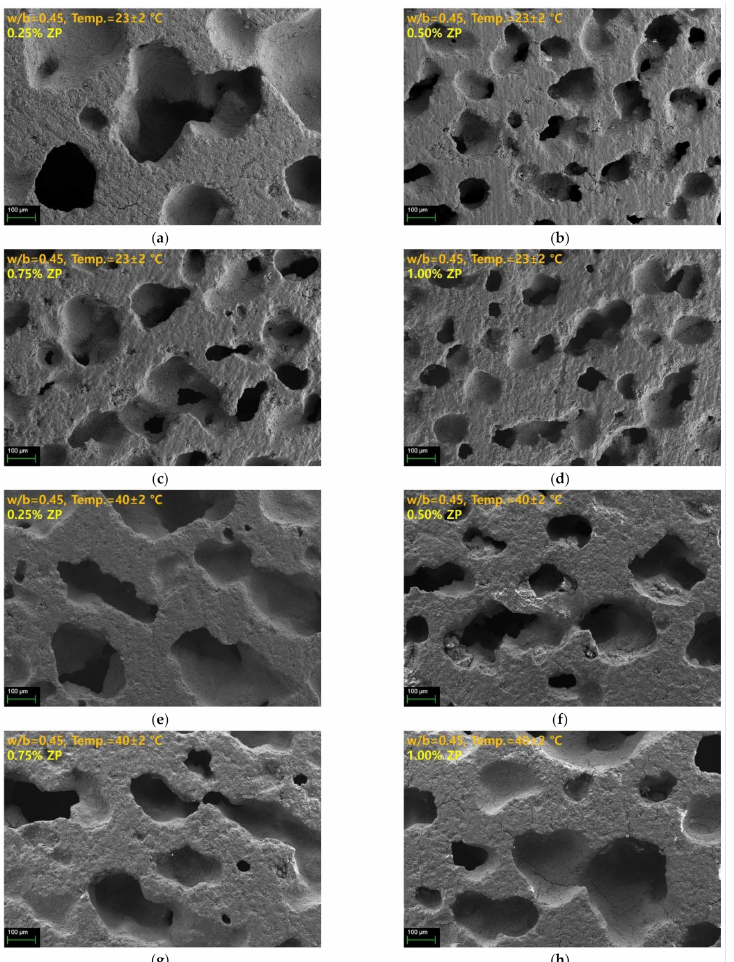
Figure 6. SEM images of samples with a w/b of 0.45 ( a ) cured at 23 ± 2 ◦ C, 0.25% ZP, ( b ) cured at 23 ± 2 ◦ C, 0.50% ZP, ( c ) cured at 23 ± 2 ◦ C, 0.75% ZP, ( d ) cured at 23 ± 2 ◦ C, 1.00% ZP, ( e ) cured at 40 ± 2 ◦ C, 0.25% ZP, ( f ) cured at 40 ± 2 ◦ C, 0.50% ZP, ( g ) cured at 40 ± 2 ◦ C, 0.75% ZP, and ( h ) cured at 40 ± 2 ◦ C, 1.00%